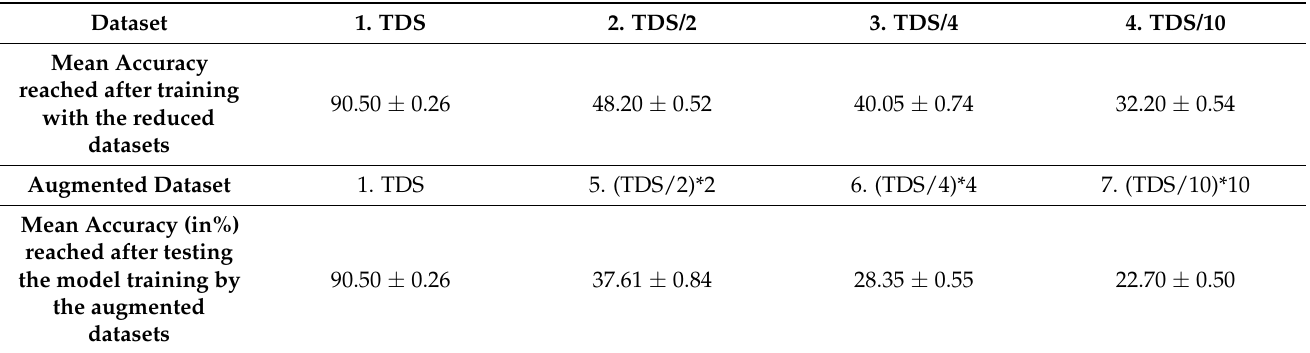
Table 7. Experiment-2: Performance comparison; TDS is the original dataset where 100 graphs are for training and 50 graphs for testing. The Numerical Augmentation ratio is Dataset × Augmentation-scale.